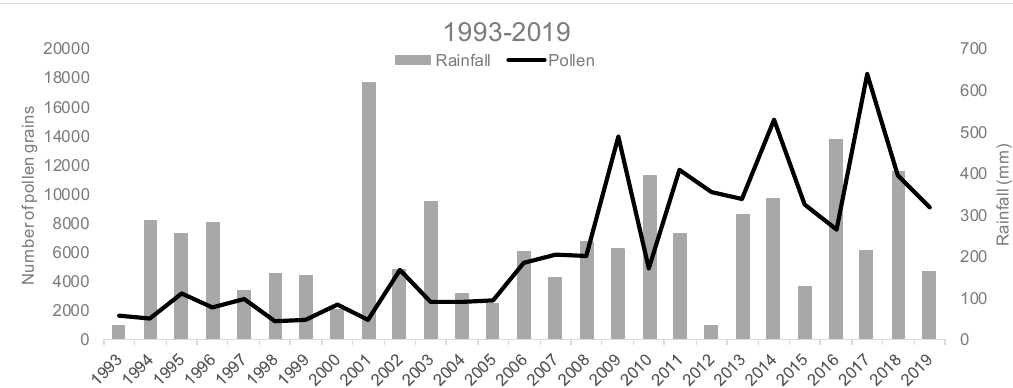
Figure 5. Trends of the airborne Quercus Main Pollen Season (MPS) characteristics during the 27 years of the study: start date, end date, length, annual pollen integral, daily pollen peak and its date.